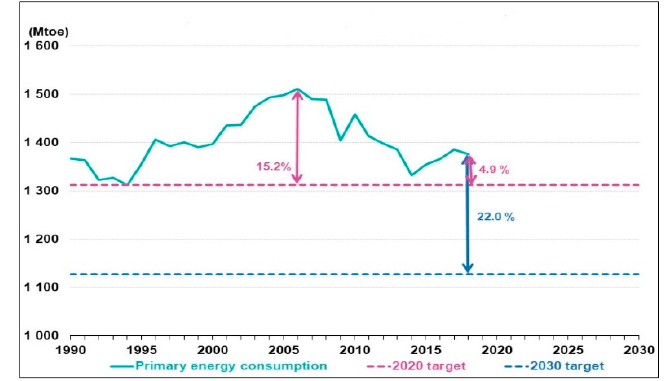
Figure 1. The primary energy consumption in the European Union (EU).